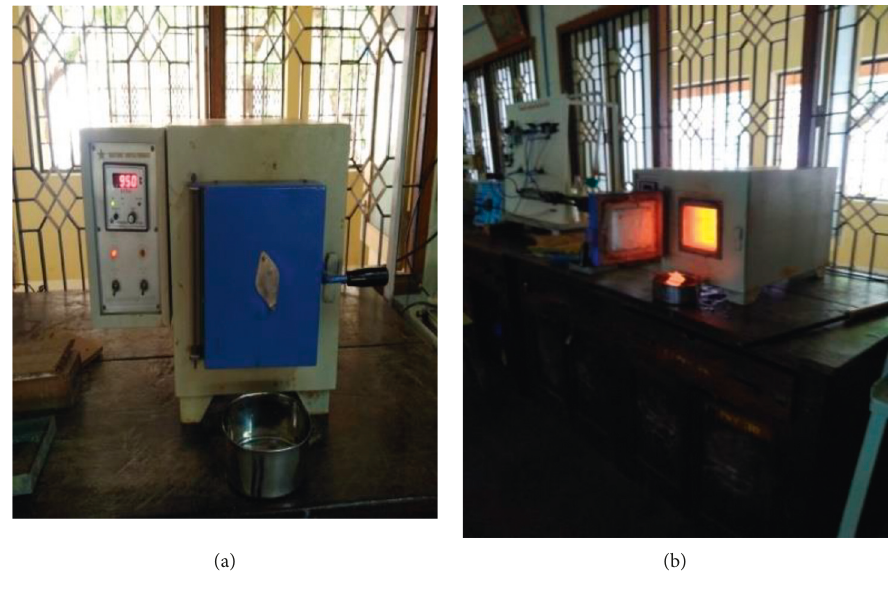
Figure 4: Solution treated and aged.